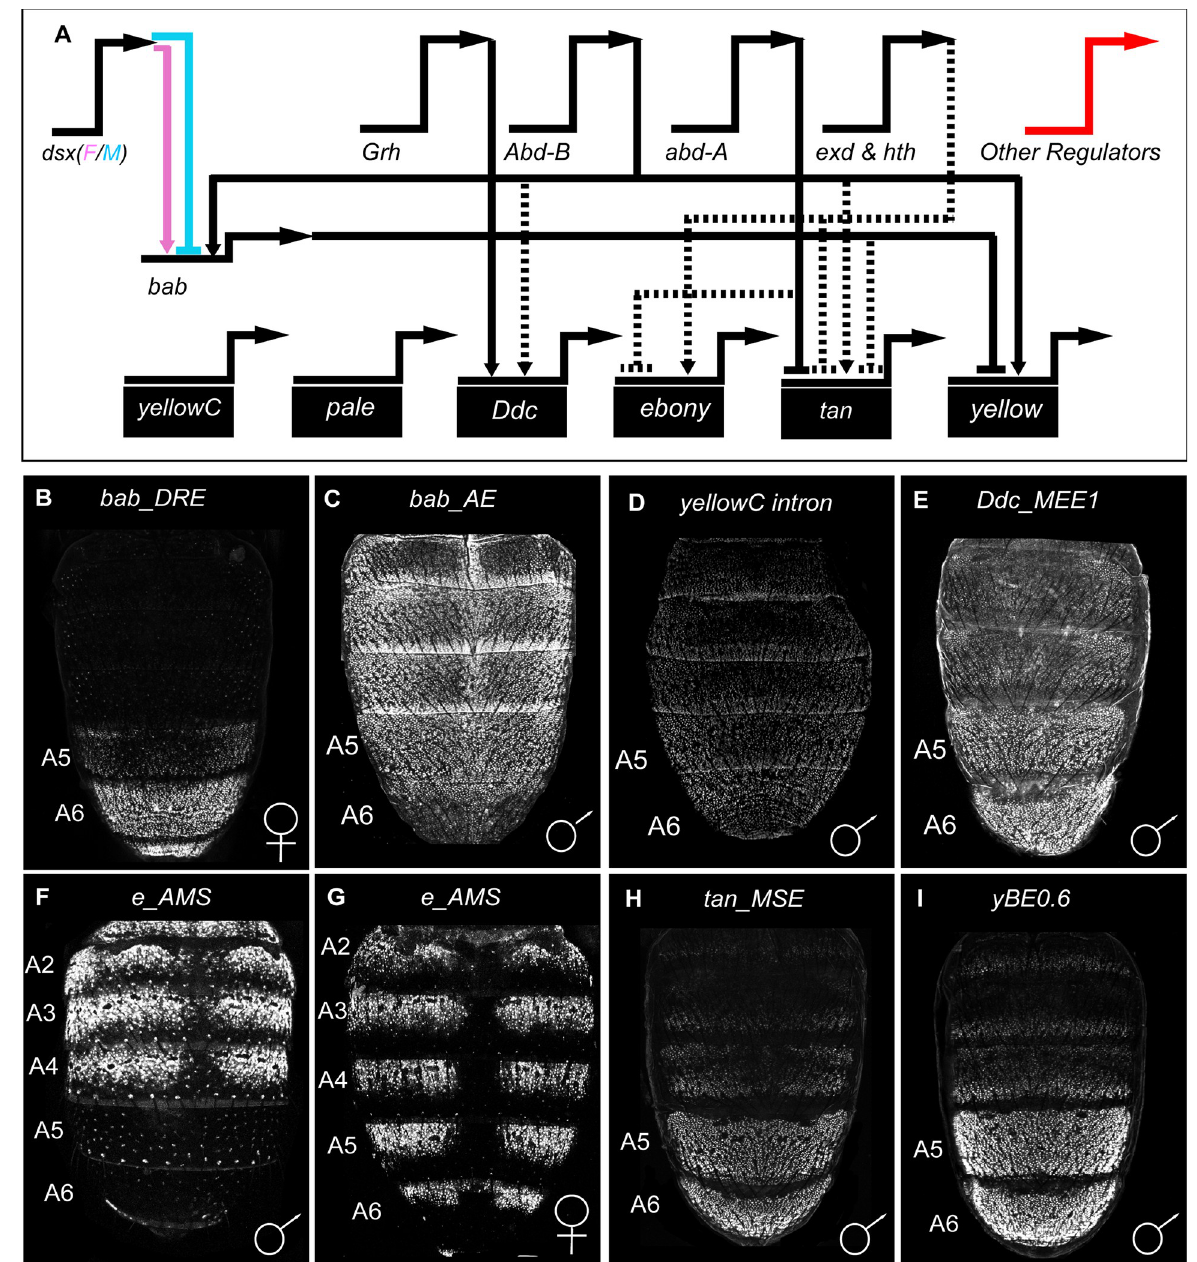
Fig 1. The known regulatory architecture and CREs for the D . melanogaster tergite pigmentation GRN. (A) Several trans -regulators are known that govern the expression of subordinate transcription factor genes, such as bab1 and bab2 (collectively referred to as bab ) and the realizator genes that encode proteins involved in pigment metabolism (gene name on black colored rectangles). It is likely that other regulators remain unknown that shape spatial, temporal, sex-specific, and/or levels of gene expression. Direct interactions between a gene’s encoded transcription factor and a target gene’s CRE are indicated by solid line connections, whereas indirect interactions or interactions for which a CRE binding site remains unknown are shown as dashed line connections. Positive regulation is represented as an arrow head and repression as a nail head shape. (B-I) EGFP reporter expressions driven by CREs that regulate a pigmentation GRN gene in vivo . All EGFP expressions shown were captured at around 80–95 hours after puparium formation (Stages P13 to P14-15i), except for F and G which are shown at ~2 hours after eclosion. (B) The bab dimorphic element (or DRE ) drives female-specific expression. (C-E) CREs that operate similarly in males and females but for which the male image is shown here for convenience. (F and G) EGFP expression driven by an ebony locus enhancer and silencer elements. (F) Notably, a silencer element represses reporter expression in the A5 and A6 segments of males. (H and I) The CREs for tan and yellow drive robust expression in the male A5 and A6 abdominal segments. These 8 CREs were used as a training set to find DNA sequences with similar motifs and that may be novel similar-functioning